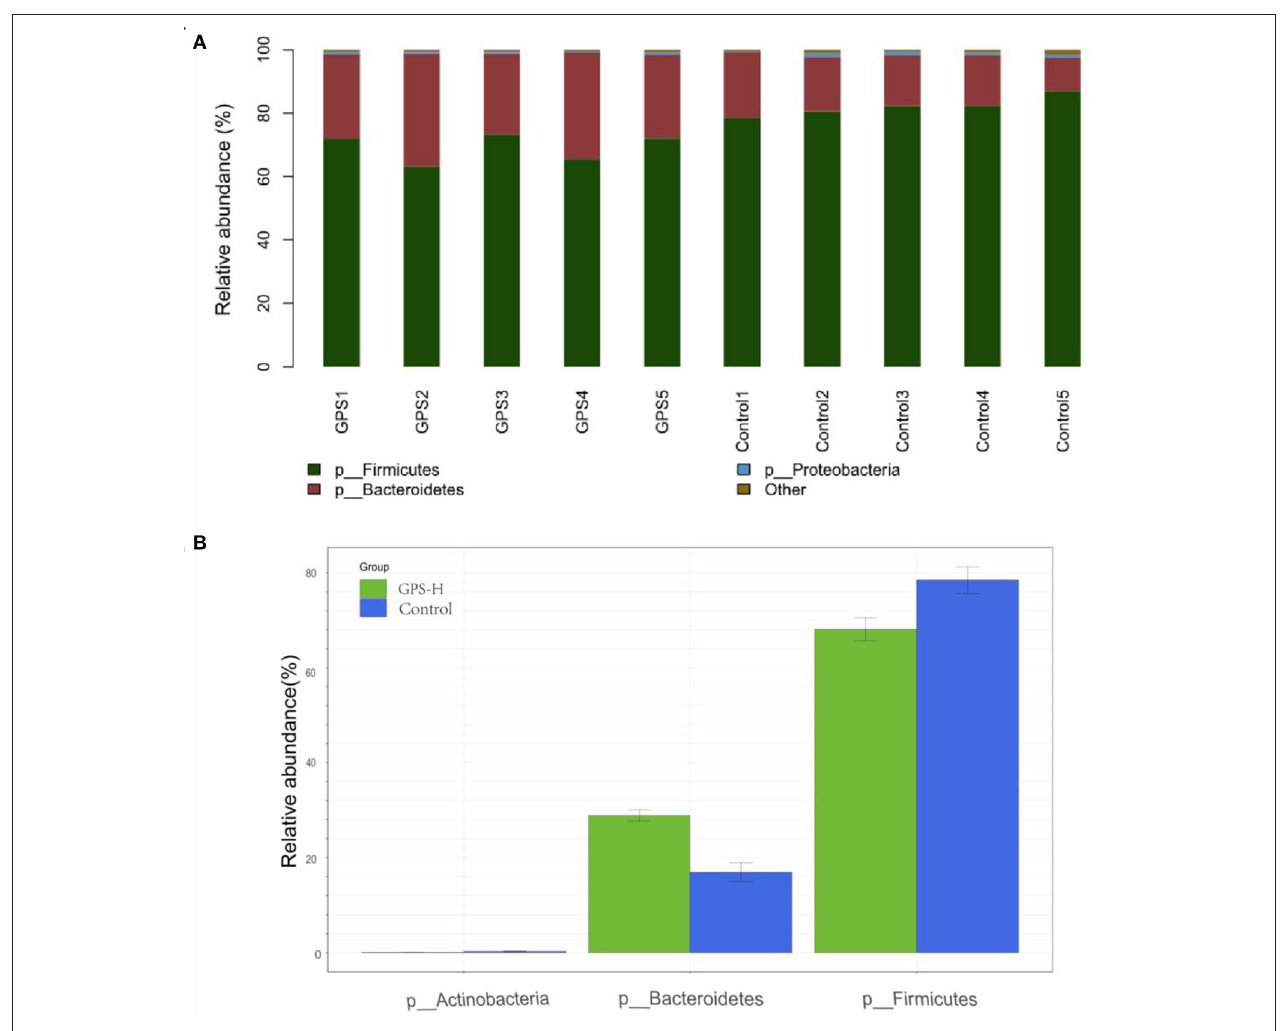
FIGURE 6 | Analysis of significant differences between two groups was analyzed using Metastats analysis, which compares multiple samples under two conditions to find the types of microorganisms that are significantly different in the two groups. Analysis of intestinal microbiota composition by phylum. (A) The specific intestinal microbiota composition in individuals in GPS-H and control groups. (B) The relative abundance of intestinal microbes between GPS-H and control